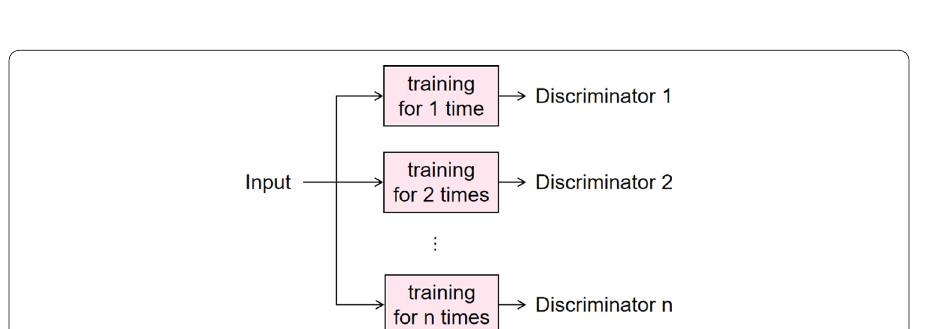
Fig. 14 The meaning of multiple training times. Multiple training times refer to sending data into the neural network multiple times, performing several epochs of training each time, and obtaining multiple discriminator networks